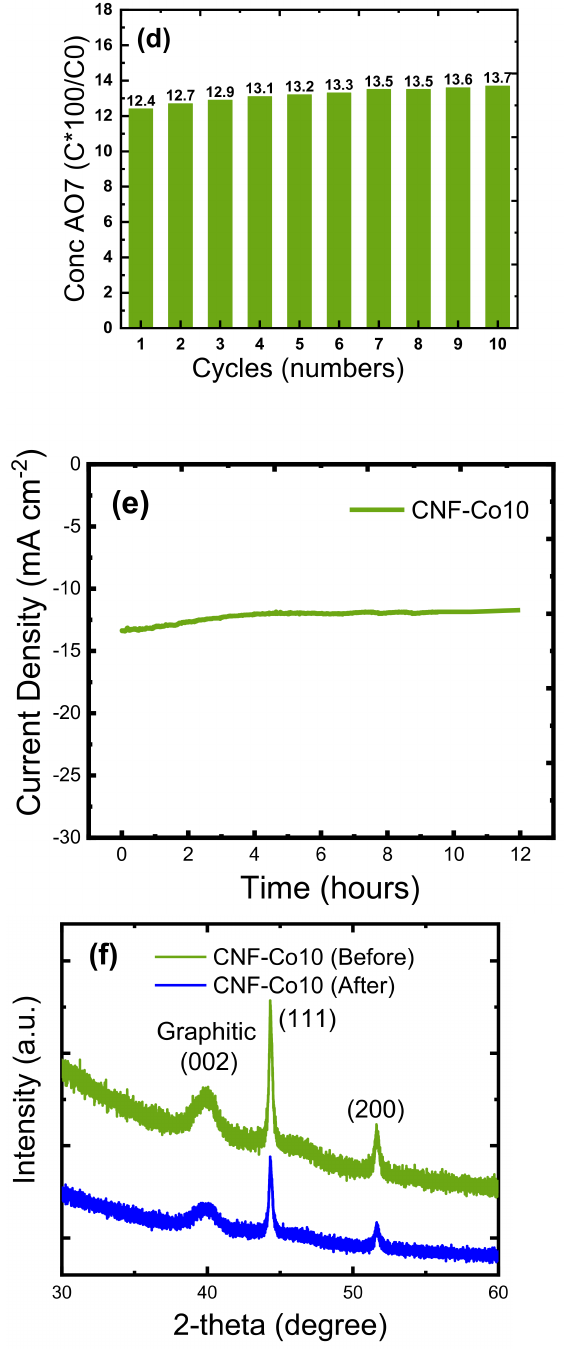
Figure 6. Influence of the cathode material on AO7 degradation ( a ) at different time points during the reaction and ( b ) after 40 min of electrolysis. ( c ) TOC removal (%) after 40 min of electrolysis. Conditions: applied current = 10 mA/cm 2 , electrolyte = 50 mM Na 2 SO 4 , initial concentration (C 0 ) of AO7 = 0.1 mM, pH value = 3, reaction temperature = 25 ◦ C. CNFs-Fe(II) is a pure CNF tested in the presence of 0.20 mM Fe 2+ as electro-Fenton reagent. ( d ) Perfor- mance of the prepared CNF-Co10 electrode: after 10 cycles of electrolysis (40 min/cycle). Con- ditions: applied current = 10 mA/cm 2 , electrolyte = 50 mM Na 2 SO 4 , initial concentration (C 0 ) of AO7 = 0.1 mM, pH = 6, reaction temperature = 25 ◦ C; ( e ) XRD patterns of the CNF-Co10 electrode after 10 cycles of electrolysis (40 min/cycle); ( f ) the chronoamperometric response (j-t) test of the CNF-Co10 electrode in 0.5 M H 2 SO 4 over 12